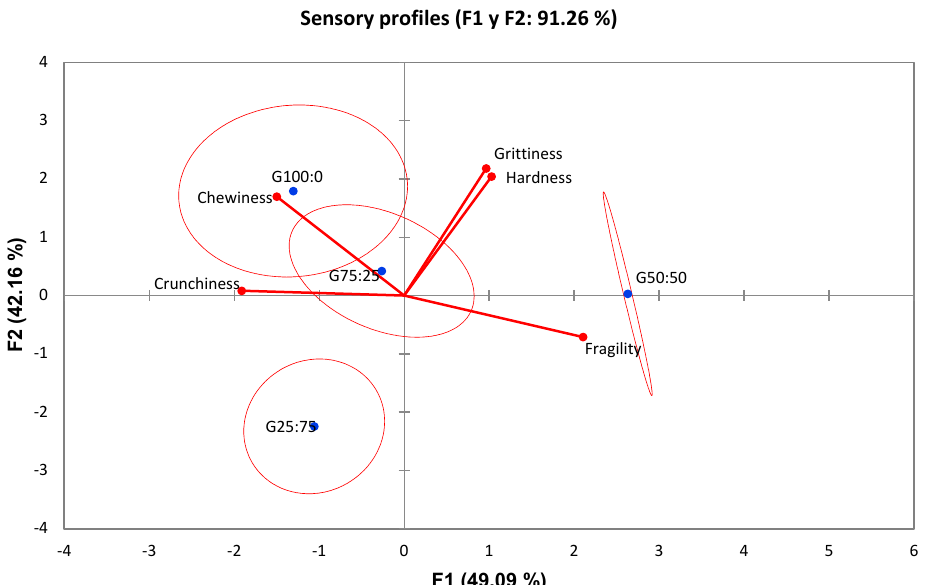
Figure 2. Principal Component Analysis (PCA) of the four chickpea biscuits formulations. G100:0 = 100% CF/0% RF; G75:25 = 75% CF/25% RF; G50:50 = 50% CF/50% RF; G25:75 = 25% CF/75% RF.